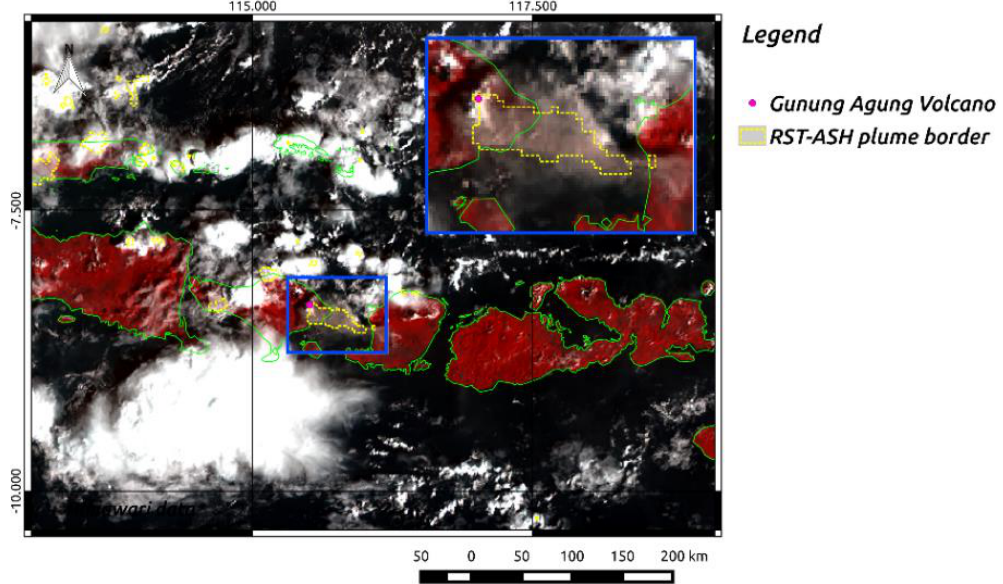
Figure 4. Himawari-8 RGB (Red = 0.86 µm; Green = 0.51 µm; Blue = 0.47 µm) product at 1 km spatial resolution 26 November at 00:00 UTC (09:00 JST). In brown, within the magnified area (at the top right side of image), the ash plume emitted by Mt. Agung (indicated in purple). Dashed lines, in yellow, correspond to borders of RST ASH detections.